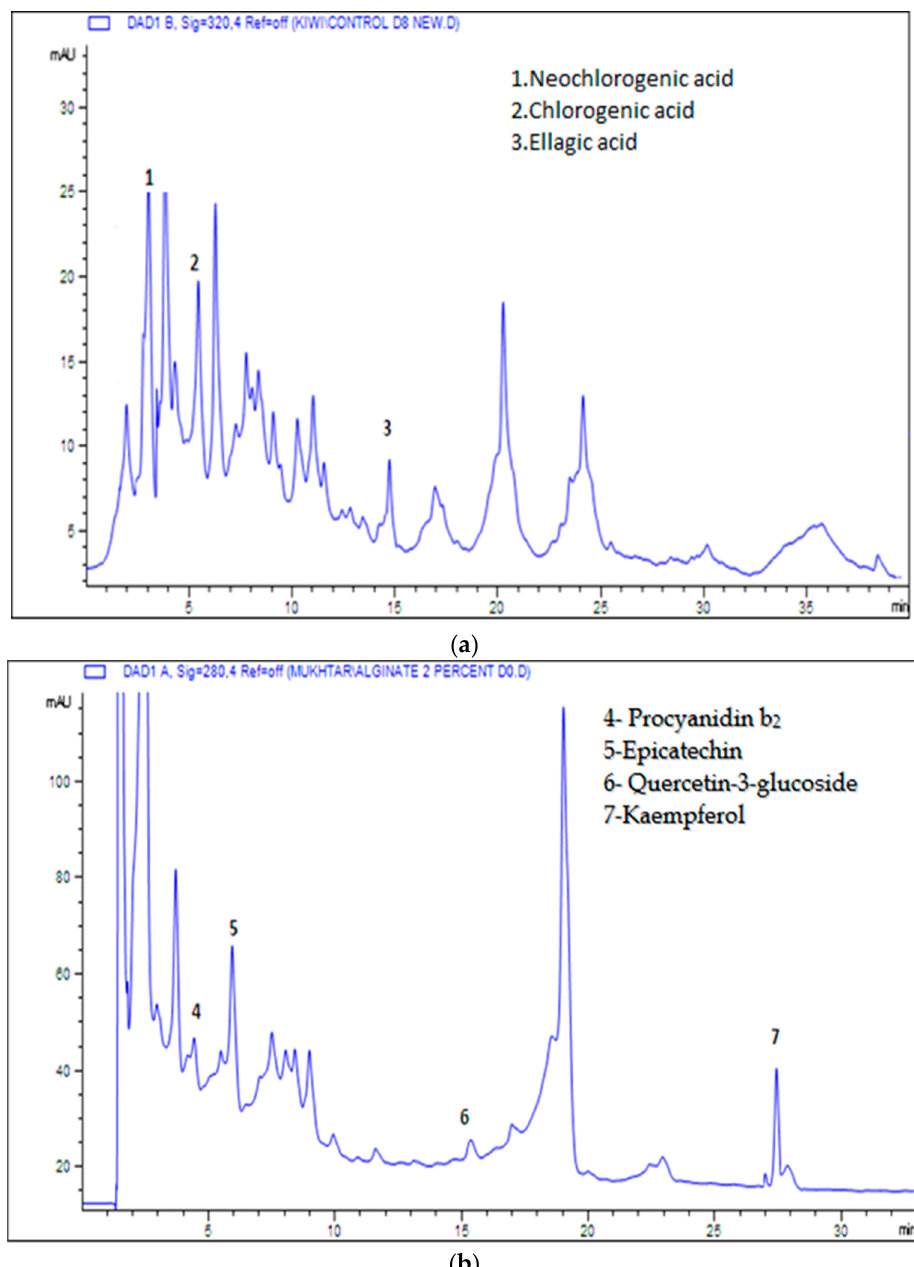
Figure 1. ( a ) Representative HPLC chromatogram of kiwi fruit slices showing polyphenols at 320 nm and 280 nm. ( b ) Representative HPLC chromatogram of kiwi fruit showing polyphenols at 280 nm.